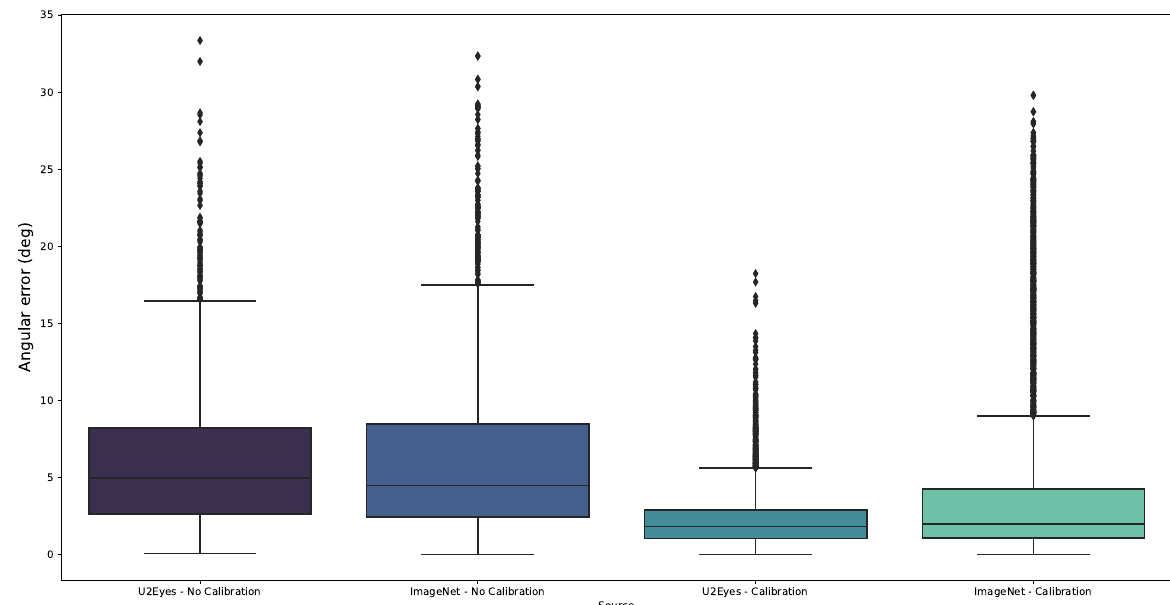
Figure 10. Another view of the results from the real environment. The angular error results for each training configuration are shown in a boxplot. The first two boxplots correspond with the experiments carried in this paper, while the third and fourth boxplot corresponds with the original experiments [24]. In the figure, when no calibration process is performed, there is almost no difference between pretraining over ImageNet or U2Eyes; however, when using calibration, the difference between the two training strategies is